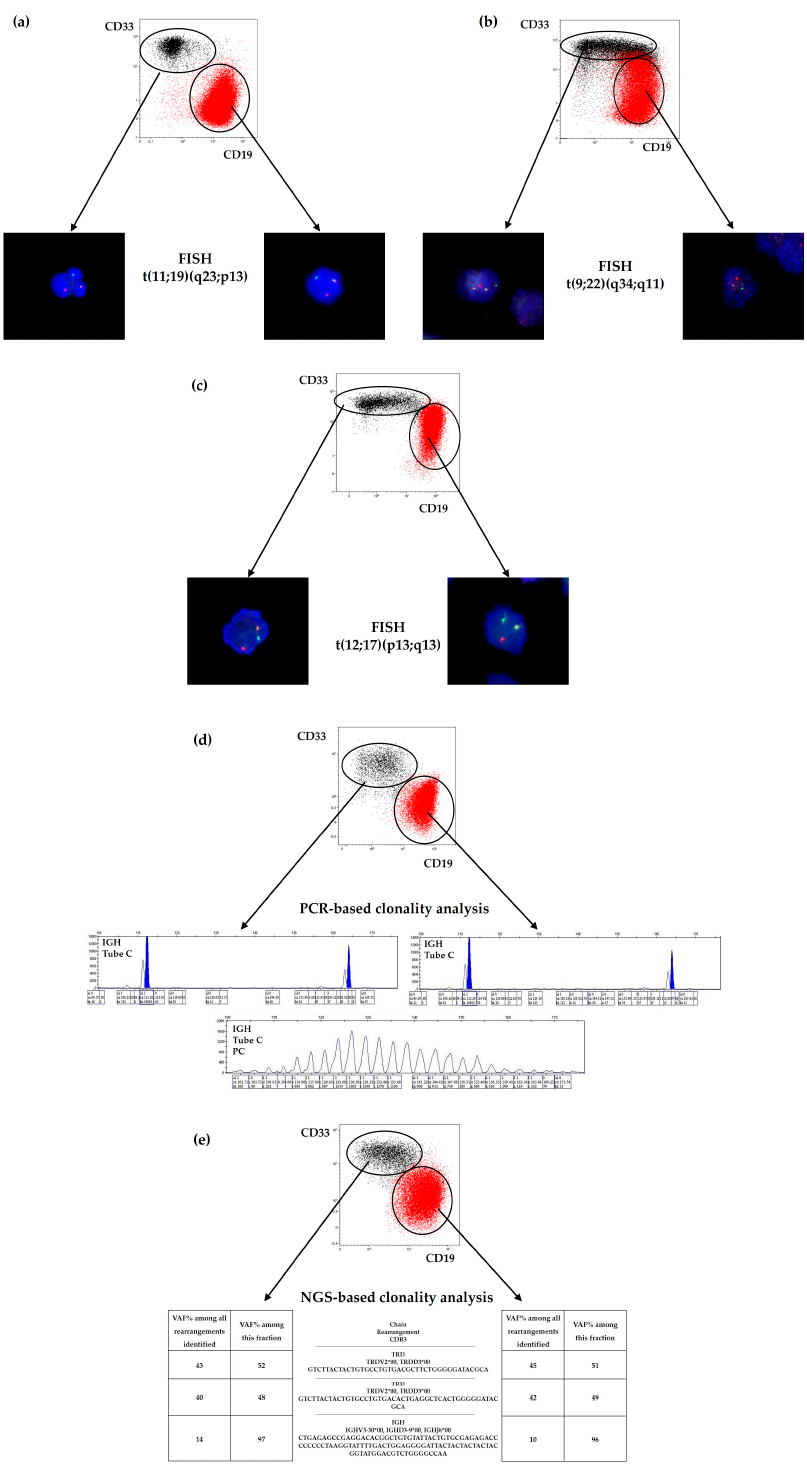
Figure 2. Confirmation of nonobvious bilineal cases of mixed-phenotype acute leukemia by cell sorting and molecular studies. Leukemic B-lymphoblasts (red) and monocyte-like cells (black) were isolated from diagnostic samples to confirm their common leukemic origin. In cases ( a – c ), FISH analysis of both cell populations confirmed the presence of specific rearrangements found previously in the bone marrow. In two other cases, the cells harbored identical IG/TR rearrangements demonstrated by either multiplex PCR ( d ) or NGS ( e